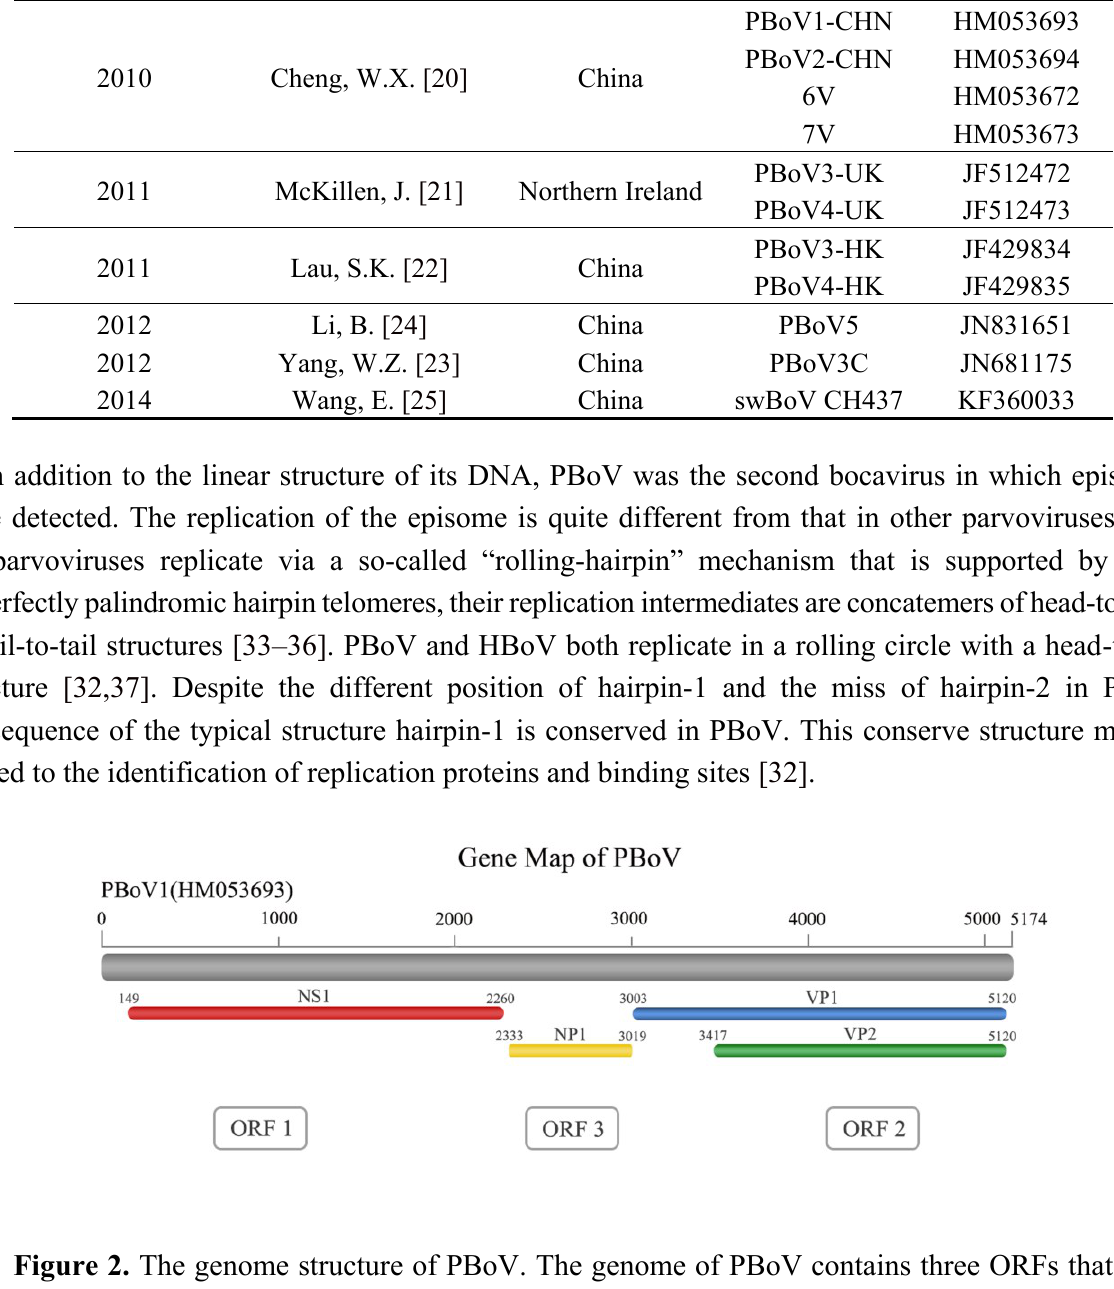
Figure 2. The genome structure of PBoV. The genome of PBoV contains three ORFs that encode four proteins. The sequences for VP1 and VP2 overlap in the